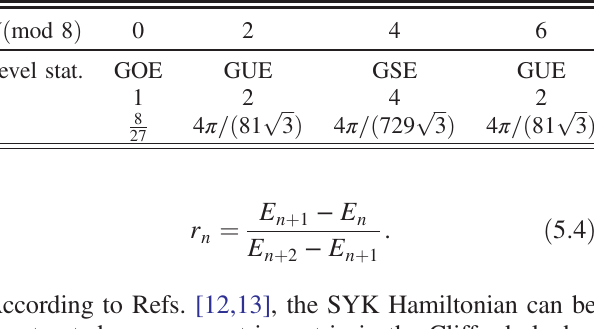
TABLE I. Gaussian ensembles for even N .